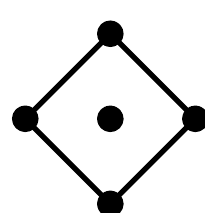
Figure 18 . 5-brane web for 5d pure SU(2) gauge theory with discrete theta angle 0.